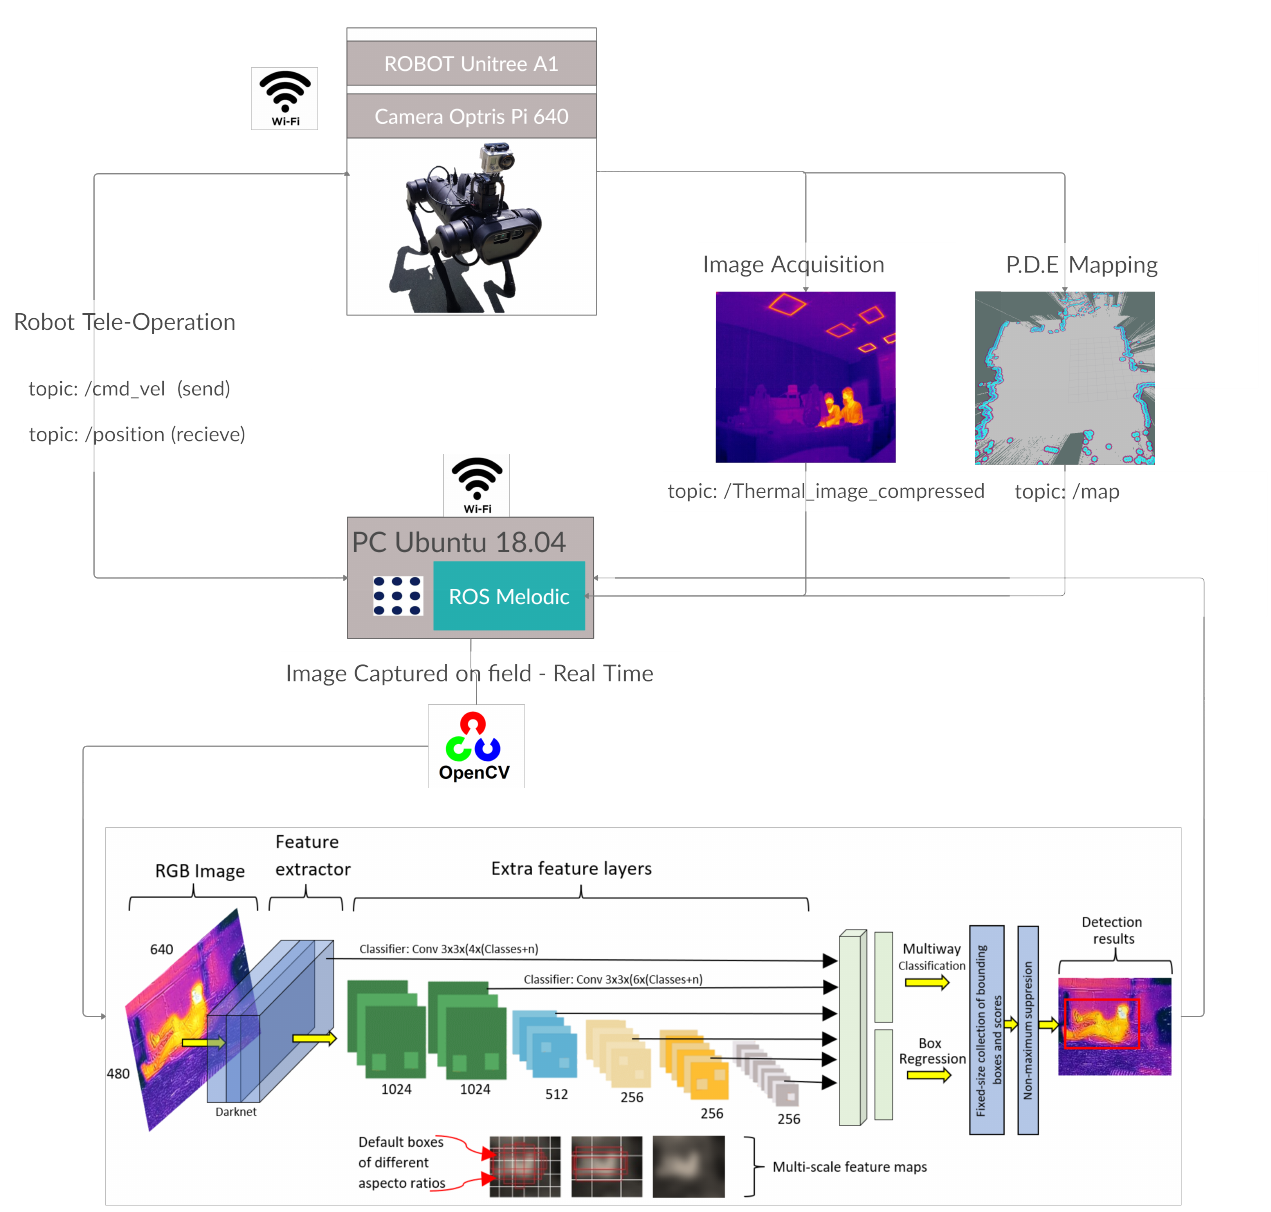
Figure 3. Subsystems integration for the detection of victims in PDE. Source: